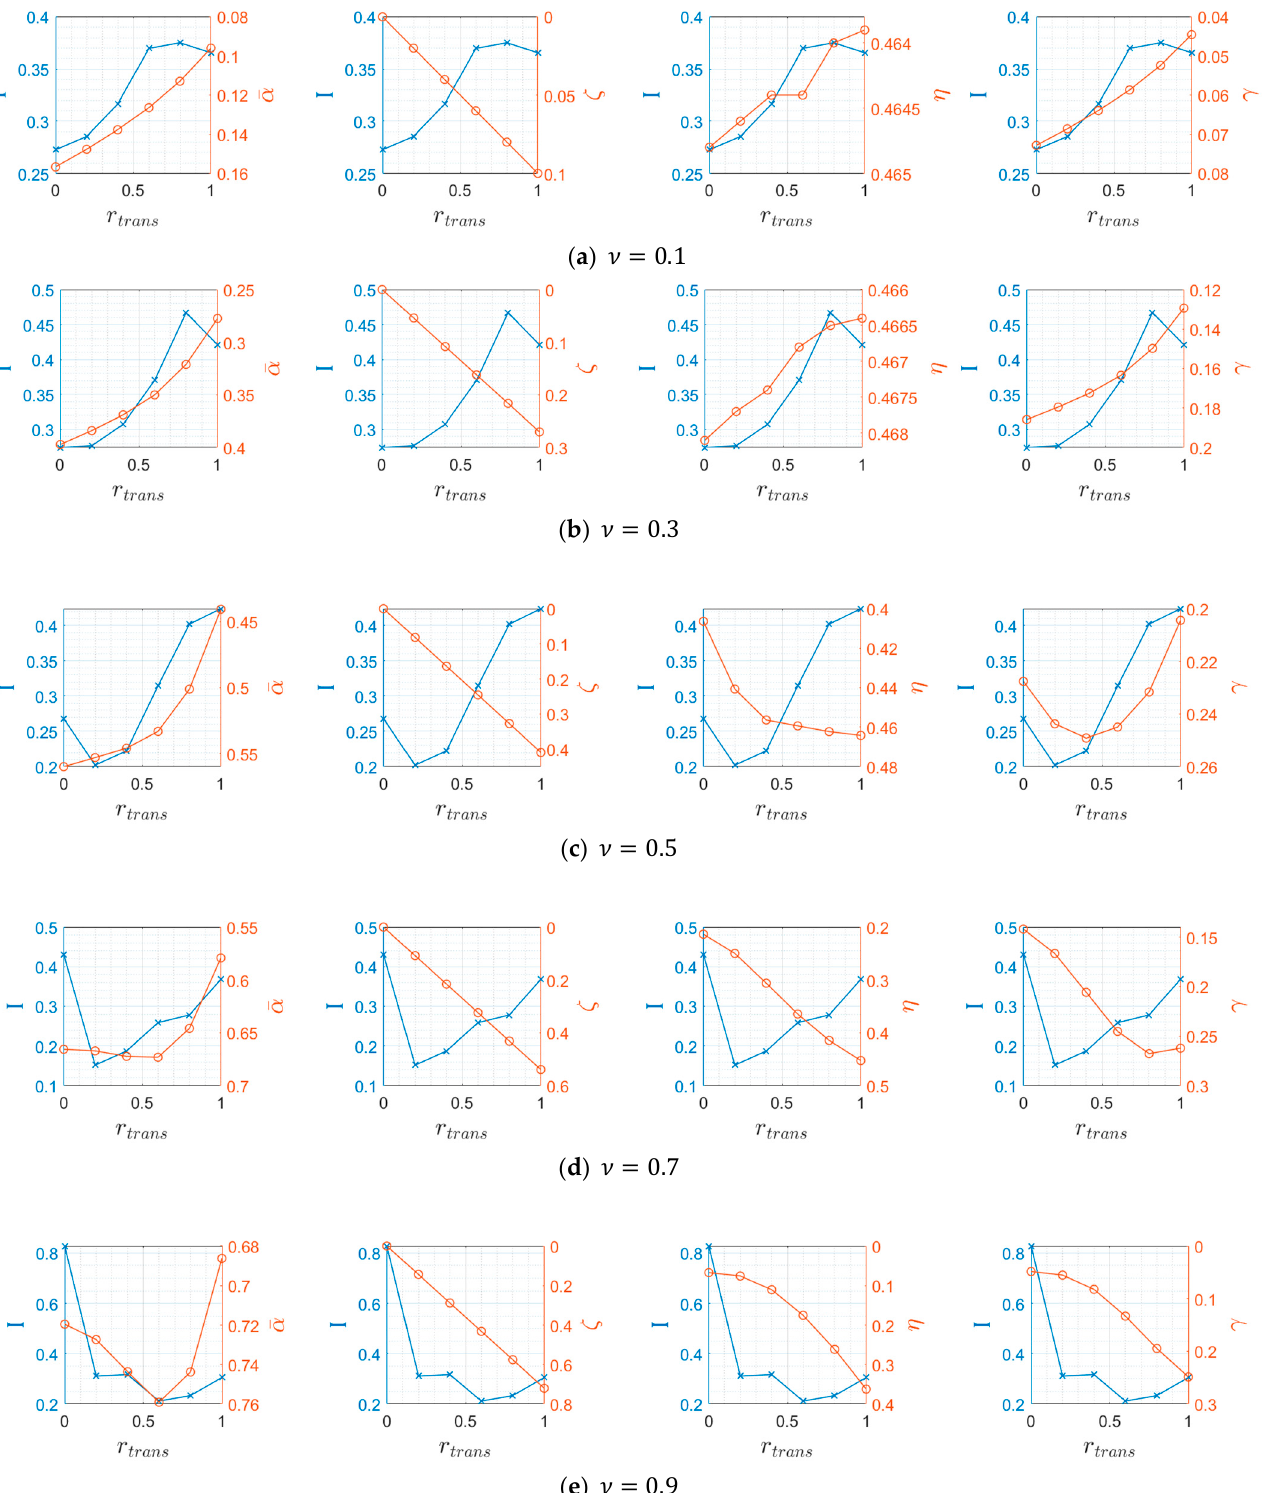
Figure 10. Comparison between I (blue lines) and c-EIs (orange lines) for µ = 1.0. From the left, the indicators are streamline crossing, the relative rate of velocity change, mobility, and the product of streamline crossing and mobility. The intensity of segregation was calculated with the identical total time, equal to 10.